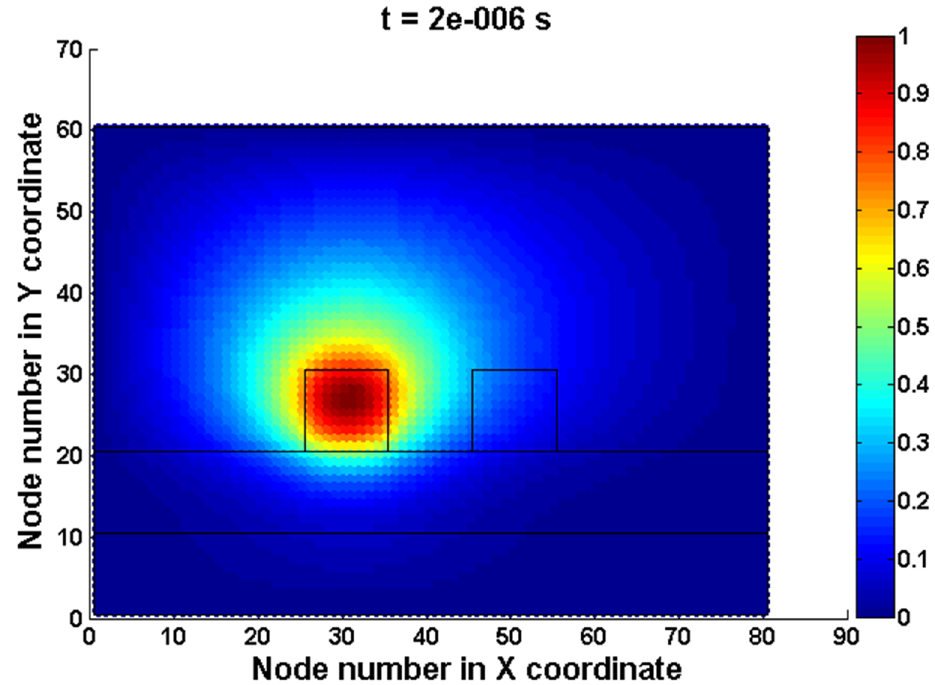
Figure 8. Steady-state temperature distribution in cross-sectional area of investigated structure. In Figure 7, the results for the heated platinum resistor were marked by dashed and dotted lines, while those ones obtained for the temperature sensor were plotted with dashed lines. Moreover, outputs for the heater and thermometer were marked by the red and blue curves, respectively. On the other hand, measurement data (collected and described in Janicki et al. [32,33]) were plotted, using green lines, while results obtained by using the F–K model were marked by the black color. The maximal temperature rise above the ambient temperature was observed at the top surface of the heat source, i.e., in the first platinum resistor (layer 3). Its value is nearly 60 K. On the other hand, the temperature rise recorded at the surface of the temperature sensor, i.e., the second platinum resistor (layer 4), is about 6 K, which states approximately 10% of the temperature rise observed in the heat source. Both of the investigated temperature rises coincide almost exactly with measurements of the real structure (green curves in Figure 7). Parameter α x allows for changing the result curves’ slopes, while DPL model parameters τ q and τ T cause the curves to shift over the time. The mentioned change is proportional to the parameters’ values. In order to check the quality of the obtained results for used the discretization mesh and mesh nodes distances (10 nm), which were described in Section 2.2, the simulation curves’ fitting to the measured one was considered. Each curve was plotted based on 703 points logarithmically distributed over the time. Then, such metrics as coefficient of determination (R2), root mean squared error (RMSE), sum of squared estimate error (SSE), and mean squared error (MSE) were calculated. Moreover, to assess the goodness of recognition as a volatility over the time, a Pearson correlation coefficient (corr) was also considered. Determined metrics values are presented in Table 3. Table 3. Evaluation of goodness of fitting of simulation results to real data . Temperature Distribution Simulation